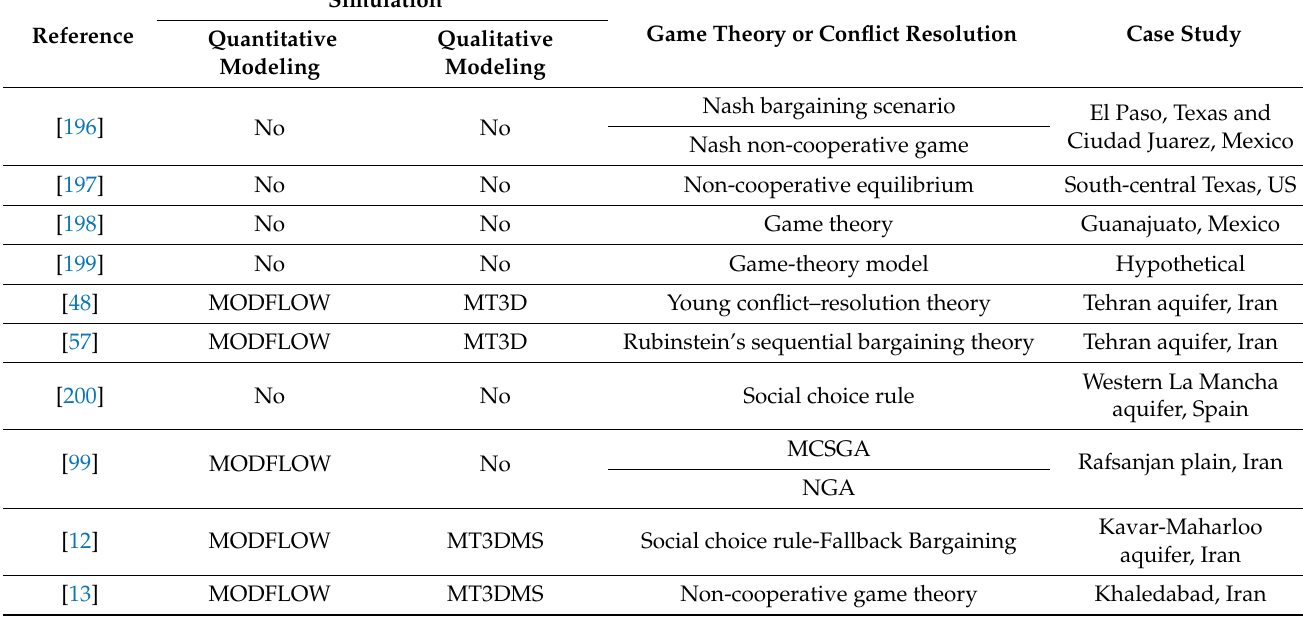
Table 6. The game theory or conflict resolution approaches in groundwater